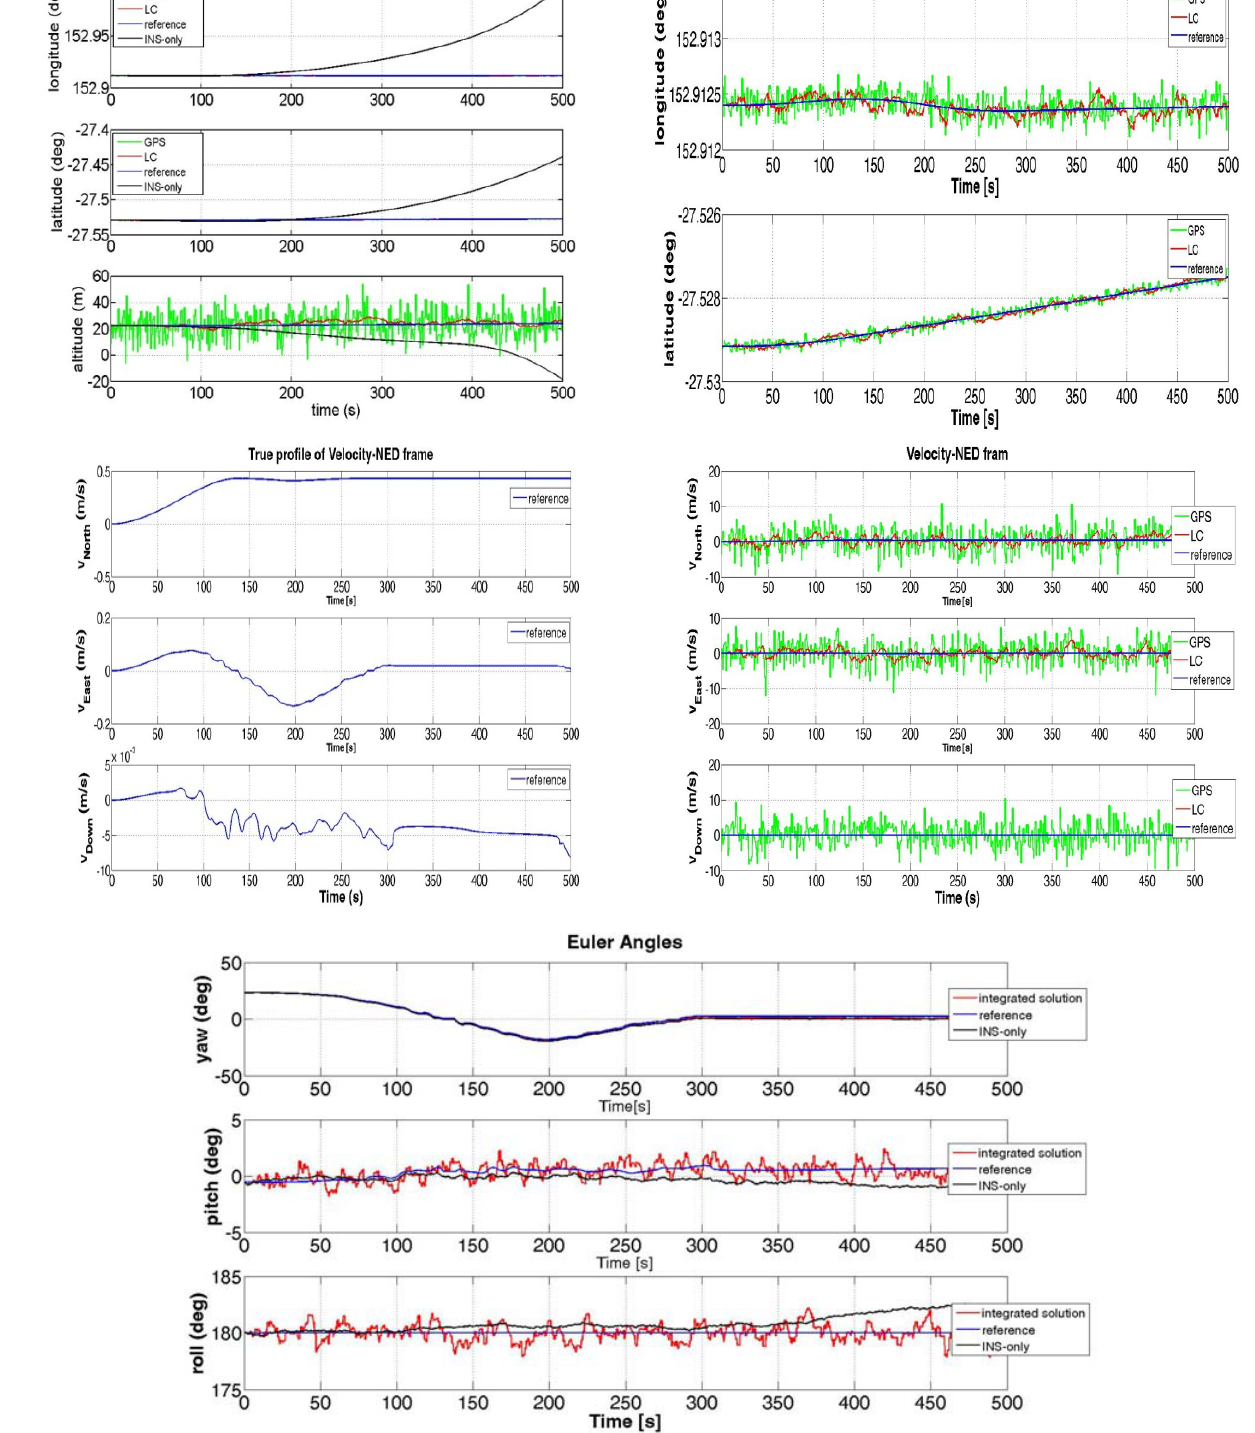
Figure 5. LC performance obtained by Simulation: Position (LLH), Velocity and Euler